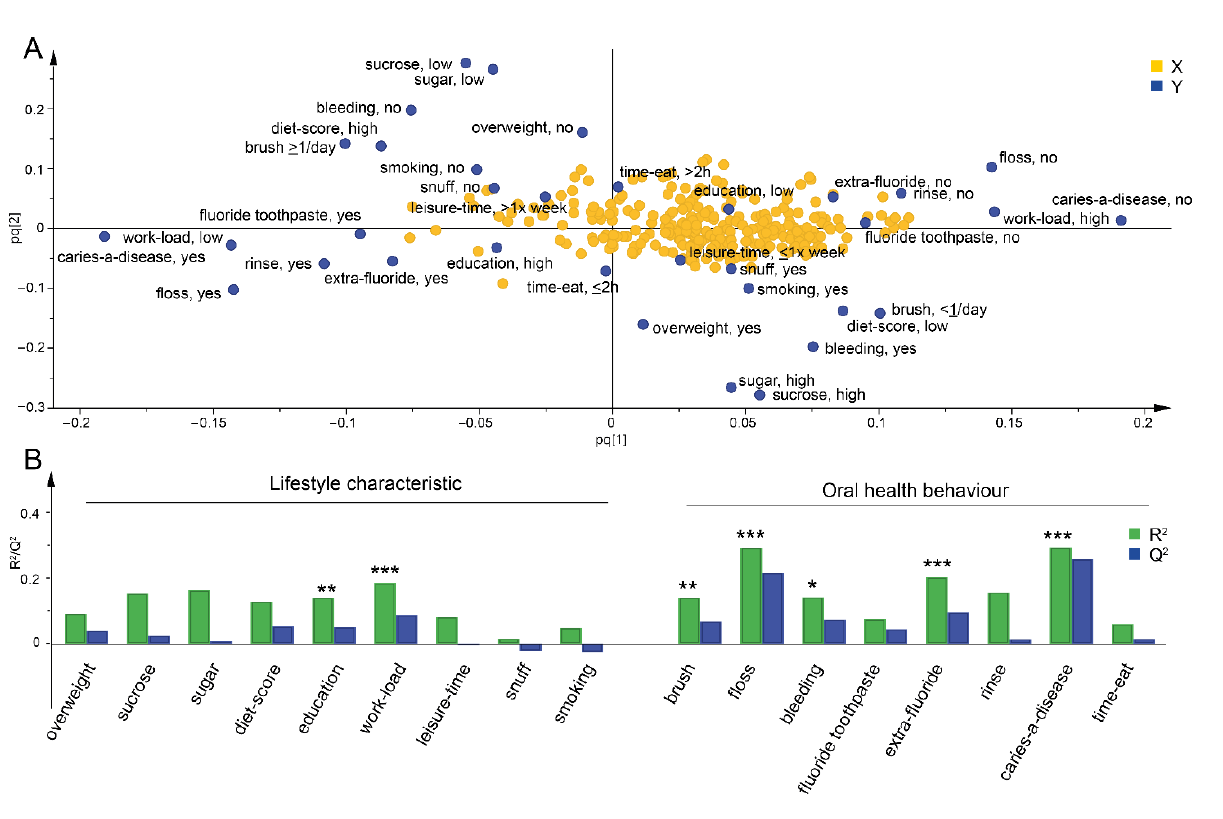
Figure 1. Lifestyle characteristics and oral health behaviours associated with oral microbiota composition. Associations between lifestyle characteristics and oral health behaviours, and saliva microbiota composition were evaluated by orthogonal partial least square regression analysis, where the oral health behaviours and lifestyle characteristics were introduced as dependent variables (y) and bacterial genus and species as independent variables (x). ( A ) A loading score plot of the generated model that illustrates the correlation between the participants’ lifestyle characteristics and oral health behaviours and the composition of their oral microbiota. ( B ) Bar plot show the R 2 value which indicates the fraction of the original data explained by the model and the Q 2 parameter indicates the fraction of the original data predicted by the 7-fold cross-validation model. * indicates significant models for indicated trait (P CV-ANOVA * < 0.05, ** < 0.01, *** < 0.001).